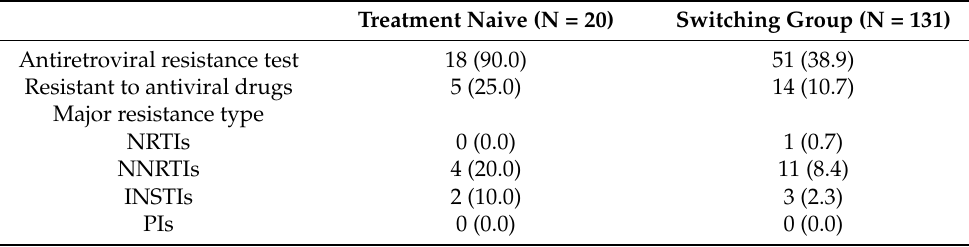
Table 3. Treatment resistance tests for the treatment-naïve and switching groups.